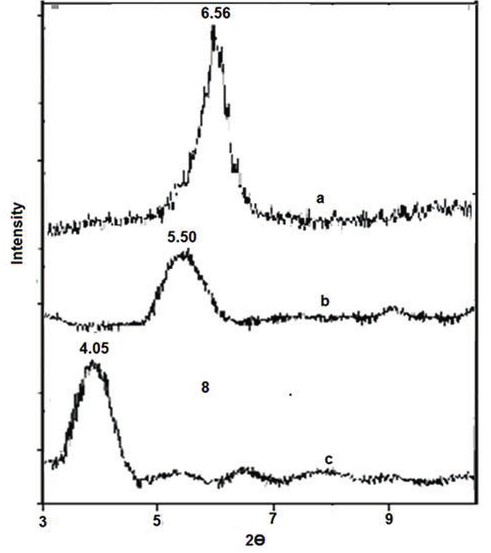
Figure 5. X-ray diffraction patterns of Organoclay ( a ), PAI- nanocomposite films 5a (b) and 5b (c)